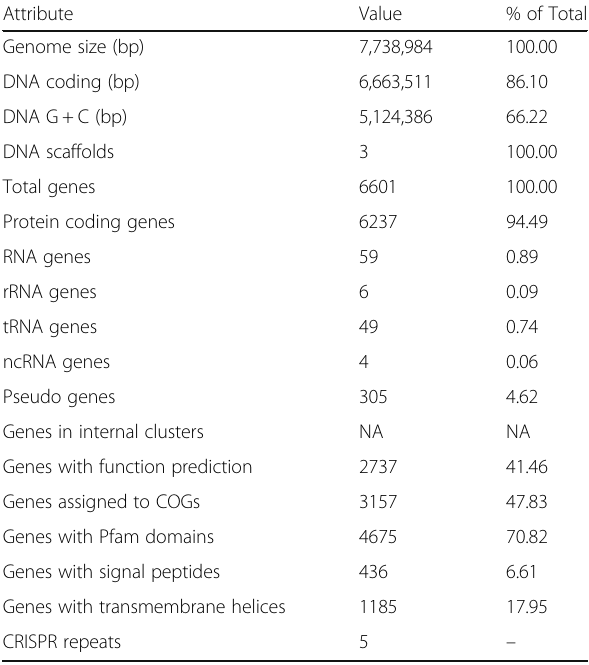
Table 4 Genome statistics for the “ T. syntrophicum ” sp.